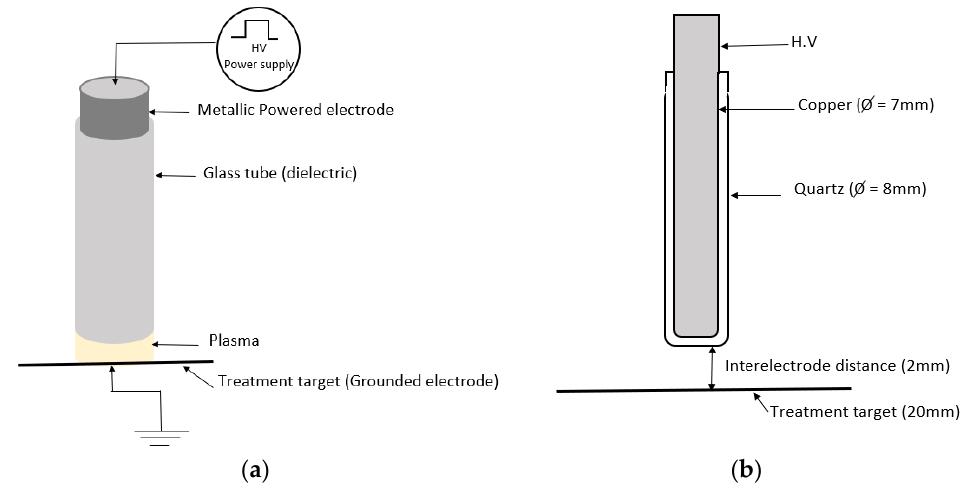
Figure 1. ( a ) Photograph of the plasma device of floating electrode dielectric barrier discharge (FE-DBD) and ( b ) schematic sectional representation of the FE-DBD treatment electrode operating with argon.